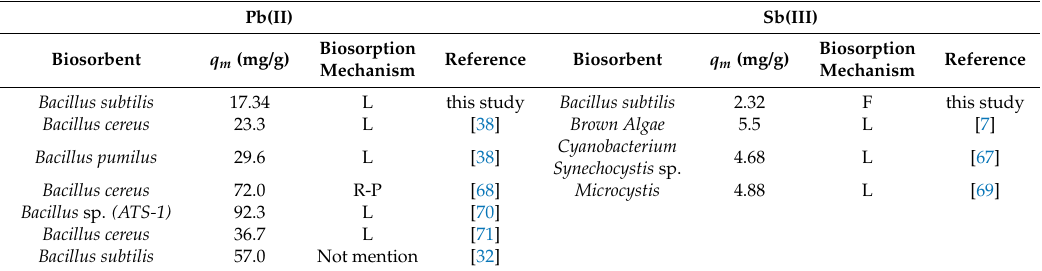
Table 5. Lead and antimony adsorption capacity with different types of biological